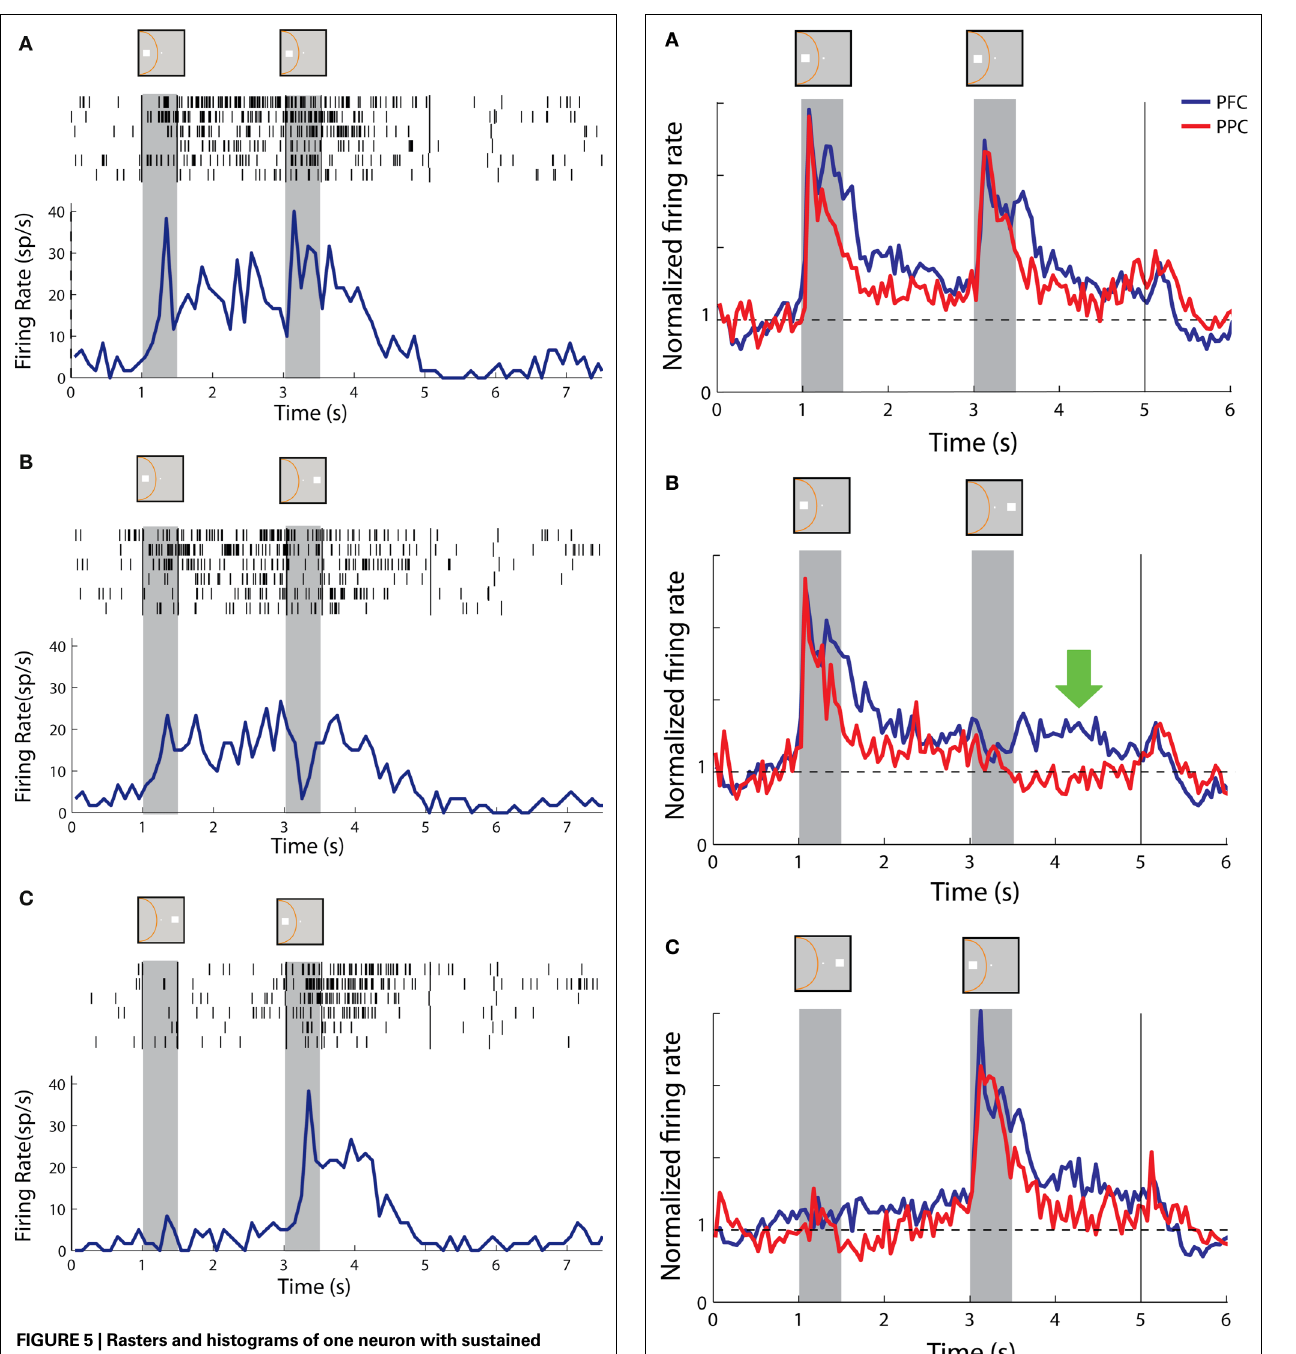
FIGURE 5 | Rasters and histograms of one neuron with sustained activity recorded from area 46 of the dorsolateral prefrontal cortex. (A,B,C) Responses to the cue followed by a stimulus in the receptive fi eld (A,C) or out of the receptive fi eld (B) , as in Figure 3 . FIGURE 6 | Population responses from neurons with sustained activity